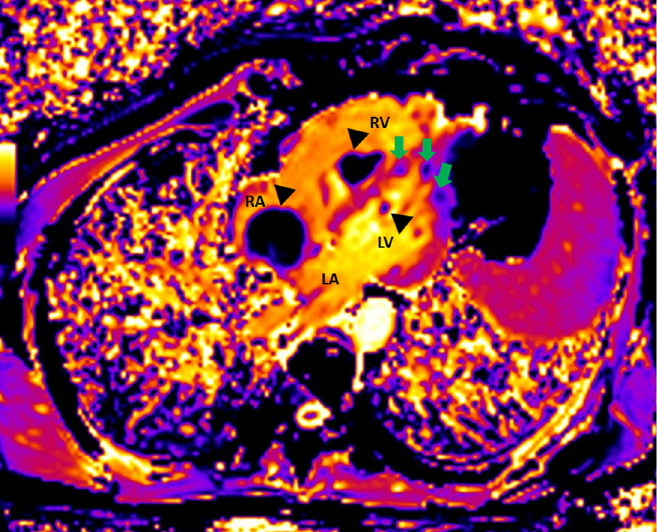
Figure 2. Cardiac magnetic resonance: Native T1 Image showing metastases in RA, RV, and LV (black arrrowheads). The lateral wall of LV and the apical interventricular septum are also infiltrated by metastatic lesions (green arrows).